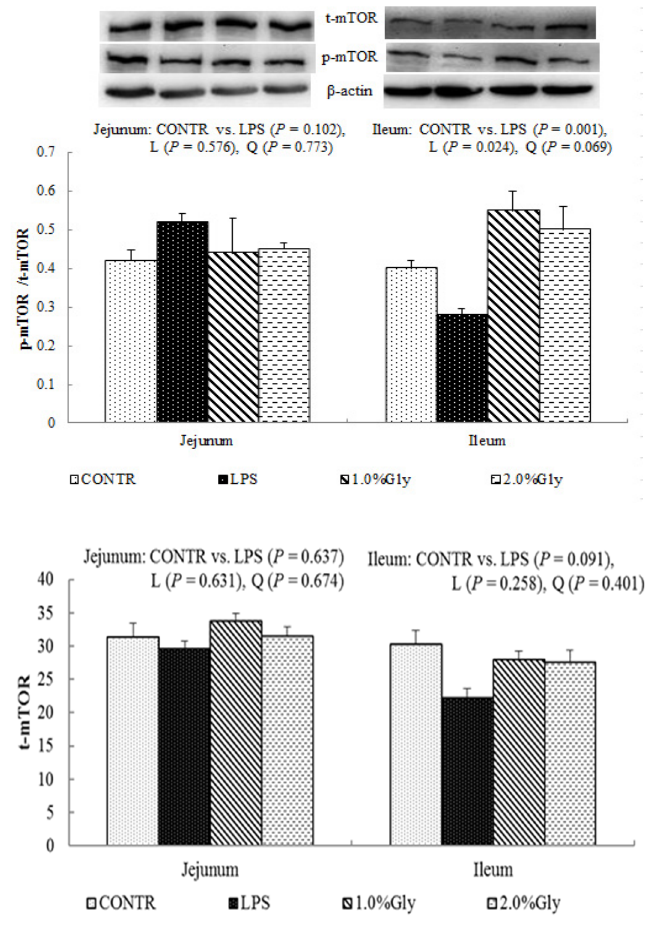
Figure 5. Effects of glycine supplementation on intestinal protein abundance of t-mTOR and p-mTOR after 4 h LPS challenge in weanling piglets. Note: L (linear), Q (quadratic).